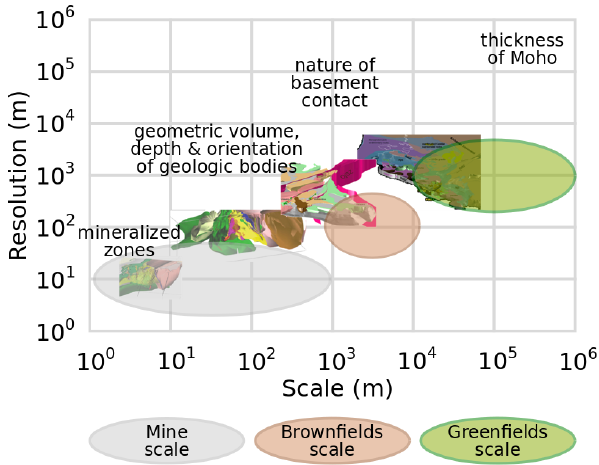
Figure 3. Modelling scales and resolutions in the mineral industry with examples of scale-specific scientific enquiry; model illustra- tions of the Vihanti-Pyhäsalmi Area, Finland, adapted from Laine et al. (2015).